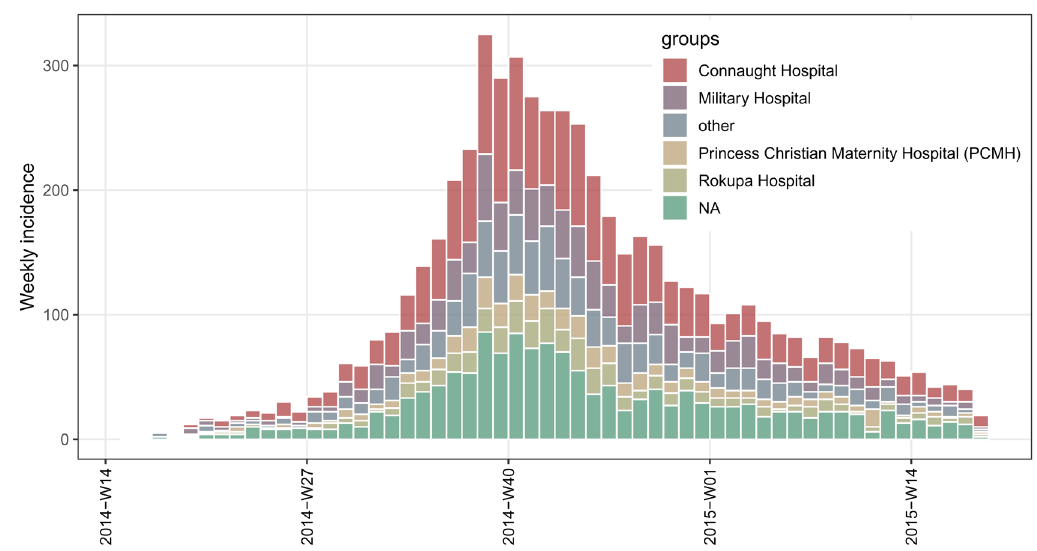
Figure 2. Weekly epicurves stratified by hospitals for the simulated outbreak of